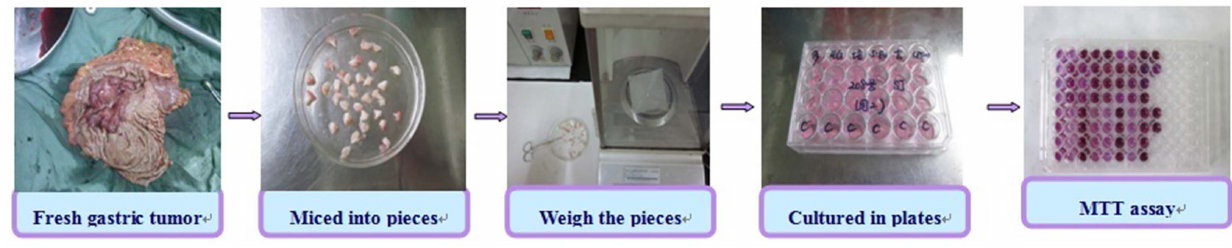
Figure 3. The procedure of histoculture drug response assay (HDRA).